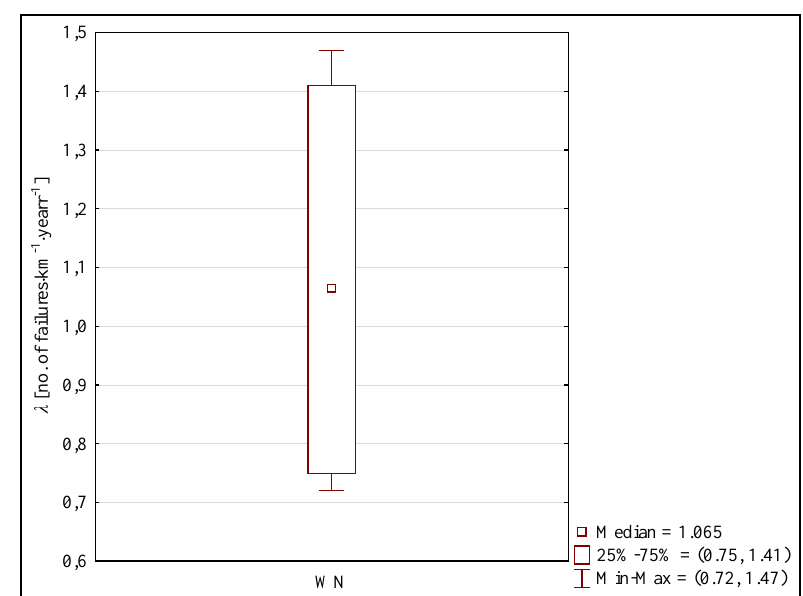
Figure 2. The failure rate for the whole water network (WN).